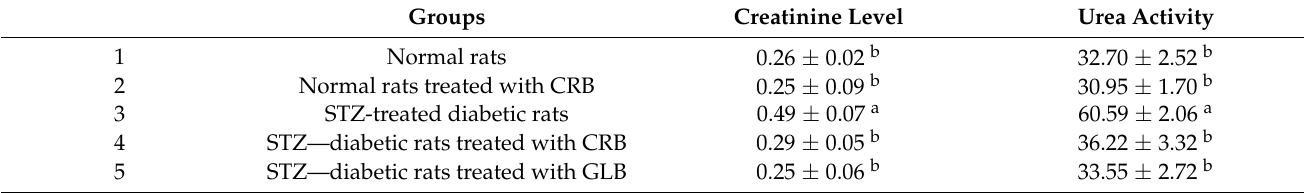
Table 5. Effect of n -butanol fraction of Colvillea racemosa total extract (CRB) orally administered